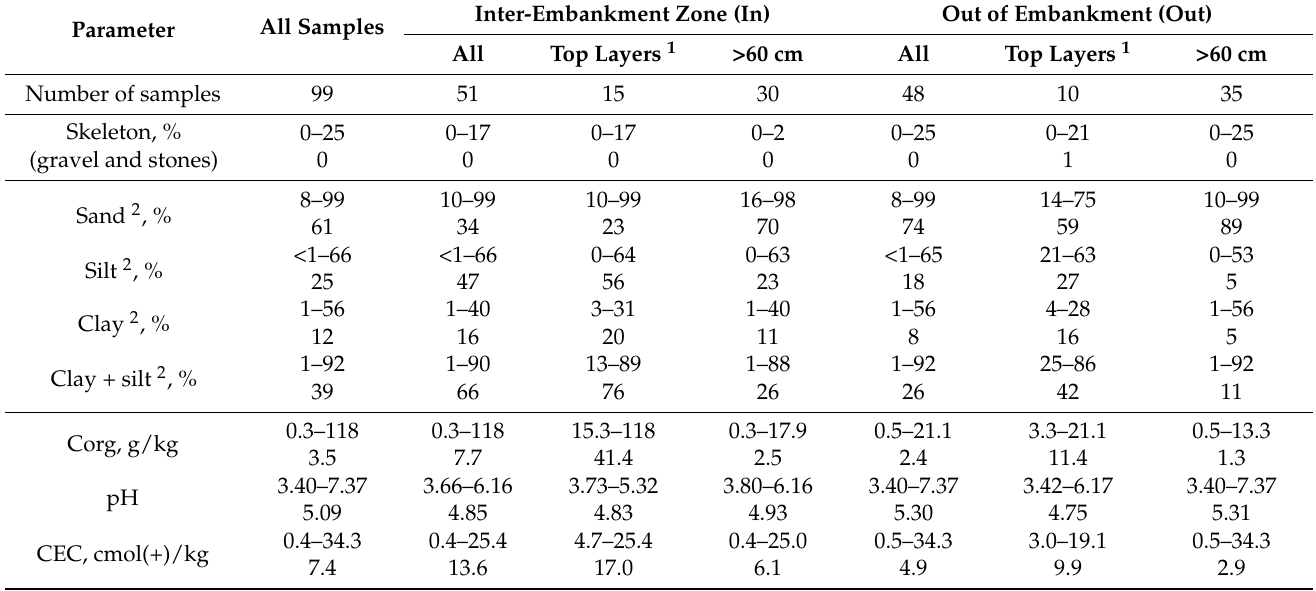
Table 1. Cumulative data on soil properties in all sampled soil samples (N = 99) and in the subgroups: inter-embankment zone (In) and out of embankment (Out), as well as (within them): the top horizons A enriched in organic matter (Top) and deeper layers (>60 cm). Presented are: Min–Max/Median